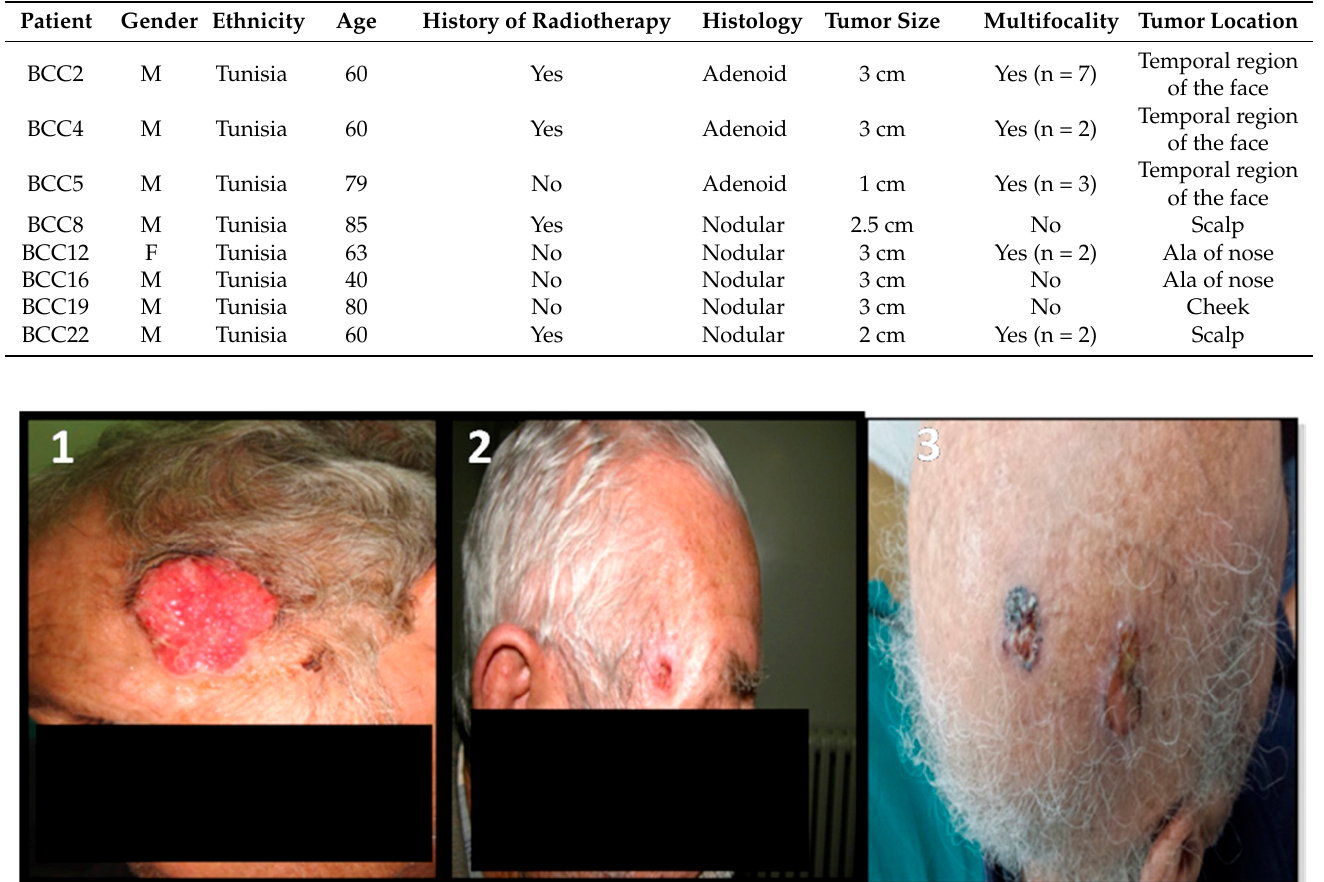
Table 1. Patients’ characteristics.